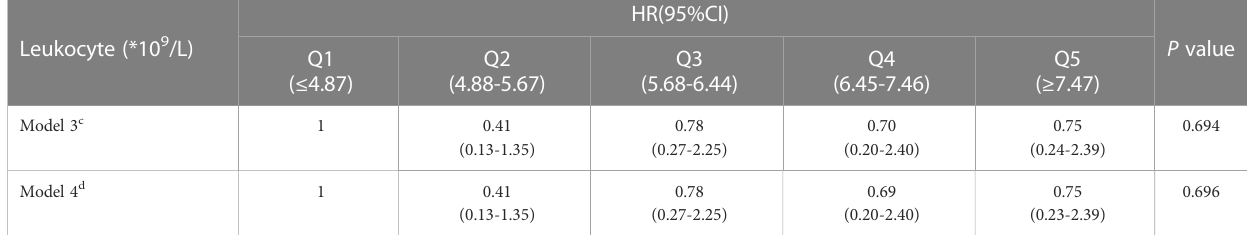
TABLE 6 Best threshold, areas under the time-dependent receiver operating characteristic curves for leukocyte, neutrophil, monocyte, and eosinophil predicting future diabetes risk.